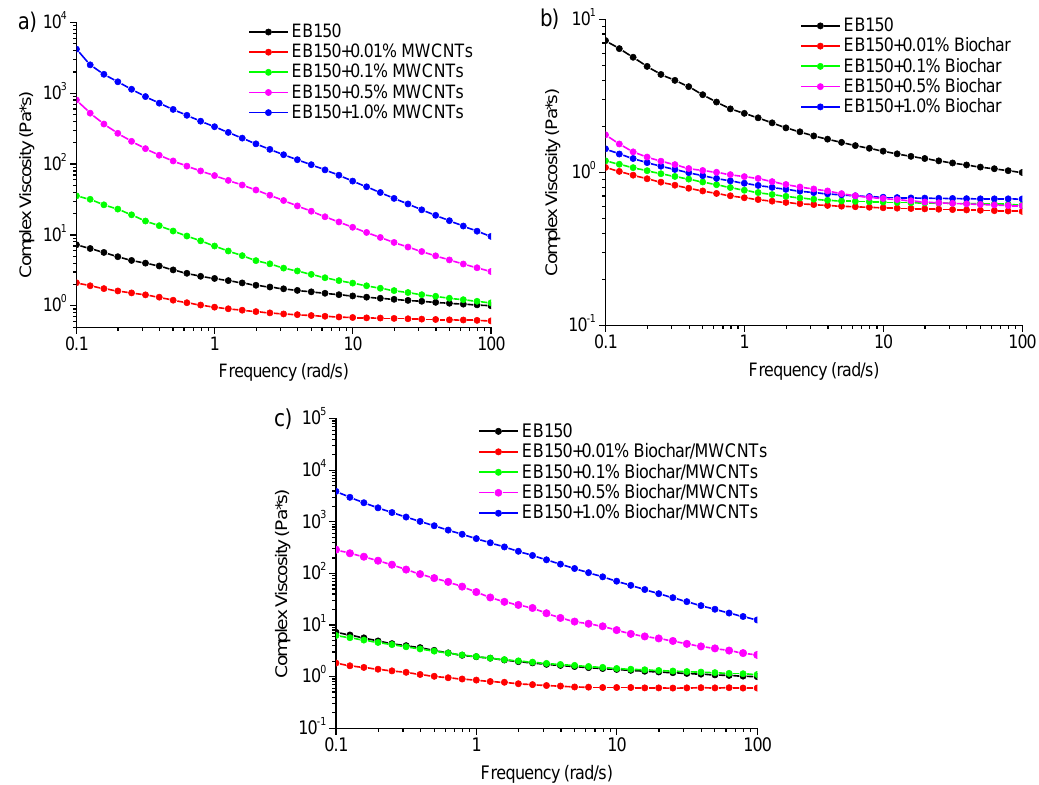
Figure 6. Complex viscosity vs. frequency curves for unfilled EB150 and EB150 + MWCNTs ( a ), EB150 + biochar ( b ) and EB150 + biochar/MWCNTs ( c ) at different loadings ranging from 0.01 to 1.00 wt %.